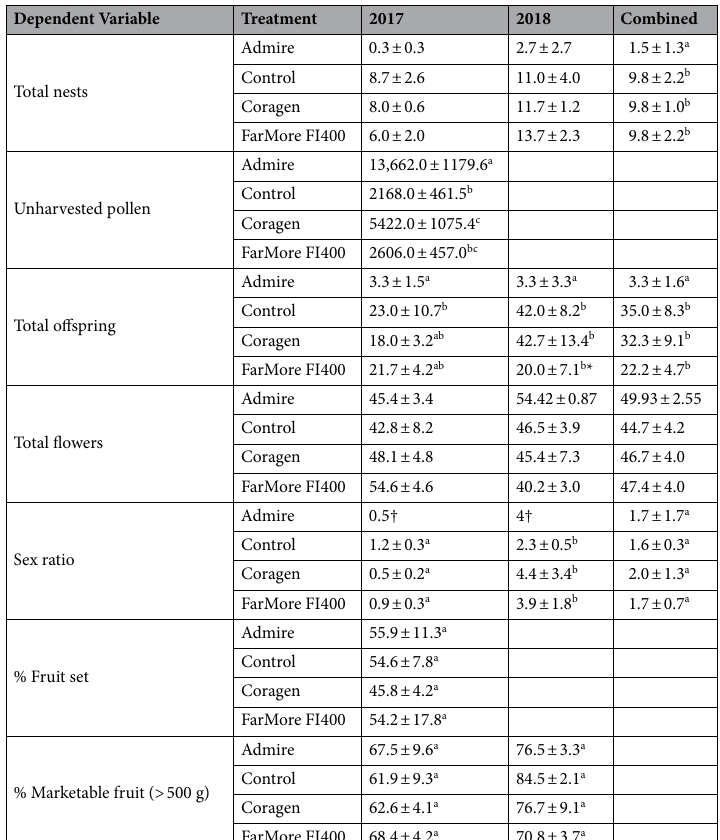
Table 1. Summary statistics (means ± standard error) for all dependent variables and insecticide treatments in each year and combined for both years. *Significant difference is marginal (p = 0.059). † Standard error could not be calculated for the sex ratio of Admire in 2017 and 2018 because bees only emerged in one hoop house in each